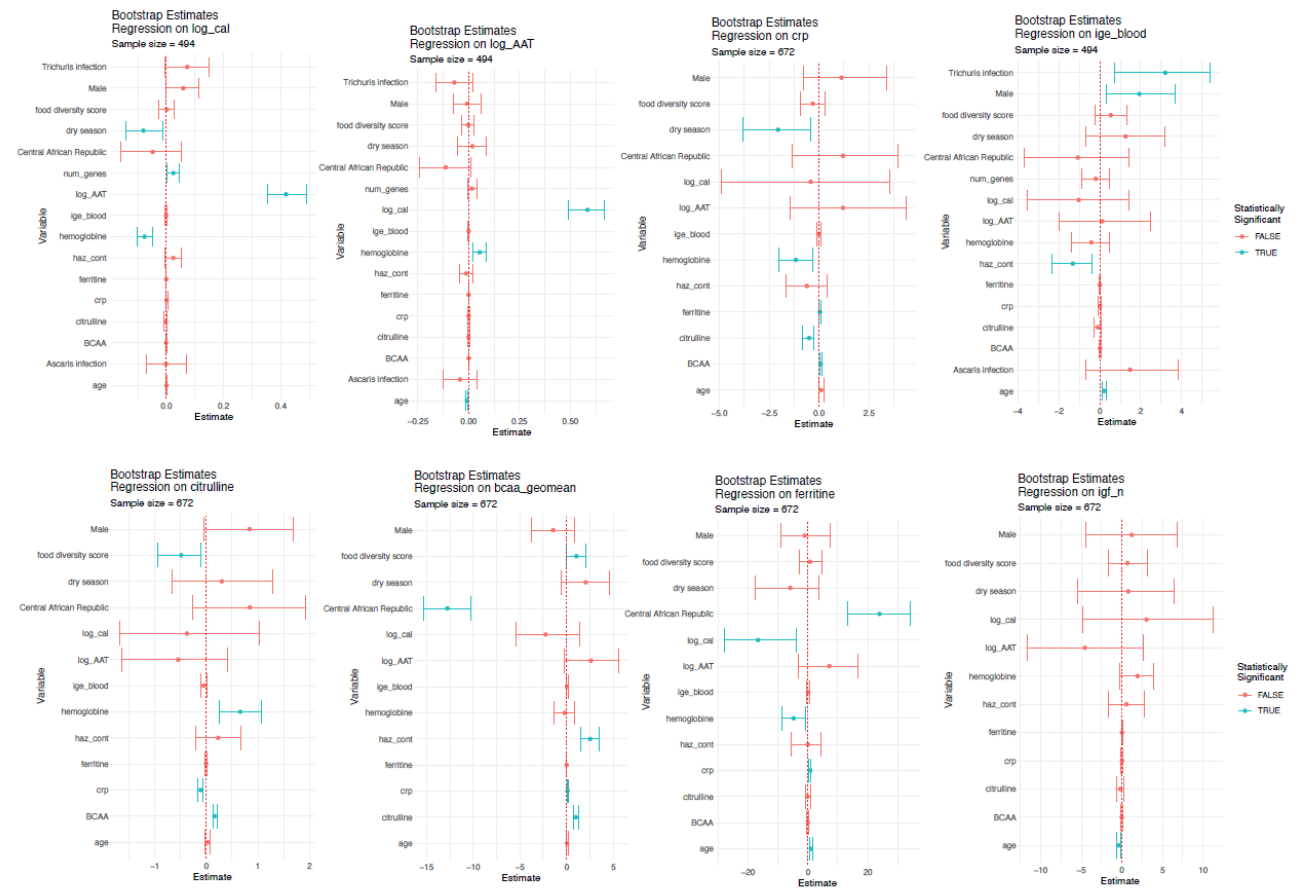
Figure 3. Factors associated with putative biomarkers of EED. Regression models are shown per biomarker, considering associations with other biomarkers as well as potential confounding factors. Significant associations ( p < 0.05) are indicated in blue.